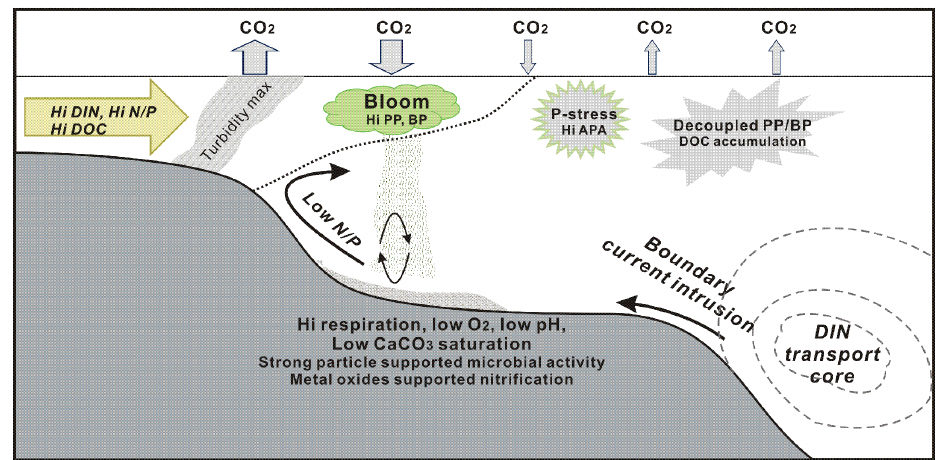
Figure 4. Schematic diagram showing the major biogeochemical features in the river–shelf–boundary current systems observed in studies of this special issue. Riverine nutrients-induced phytoplankton bloom in the river plume draws down p CO 2 (Chen et al., 2013) and produces high particulate organic carbon (POC) flux (Hung et al., 2013), which causes strong community respiration (Chen et al., 2013) probably driven by active resuspension (Hung et al., 2013). The elevated particle concentrations near the river mouth sustain exceptionally high microbial activities, which include nitrification processes facilitated probably by the particle-borne metal oxides (Hsiao et al., 2014). Consequently, low oxygen, low pH and low aragonite saturation occur in the bottom water beneath the surface algal bloom in the Changjiang river plume and also in the YS (Chou et a., 2013b; Zhai et al., 2014). Although the riverine nutrient loads in east Asia are often enriched in dissolved inorganic nitrogen (DIN) resulting in high N / P ratio, P-limitation does not happen in the river plume because of the nutrient supply with low N / P from the marine origin provided by upwelling and entrainment associated with the river plume (Y. F. Tseng et al., 2014). Instead P-stress occurs in the outer rim of the river plume and often induces high alkaline phosphatase activities (AKA). The nutrient supply from marine origin is often actuated by intrusion onto the shelf from boundary currents, such as the Kuroshio, which carries a large nutrient load with a subsurface core (Guo et al., 2013). In the inner shelf where nutrients are replete, primary production (PP) and bacterial production (BP) are tightly coupled driving a rapid turnover of dissolved organic carbon (DOC), whereas, in the oligotrophic outer shelf, the two are decoupled and DOC tends to accumulate due to low turnover rate (Lai et al.,